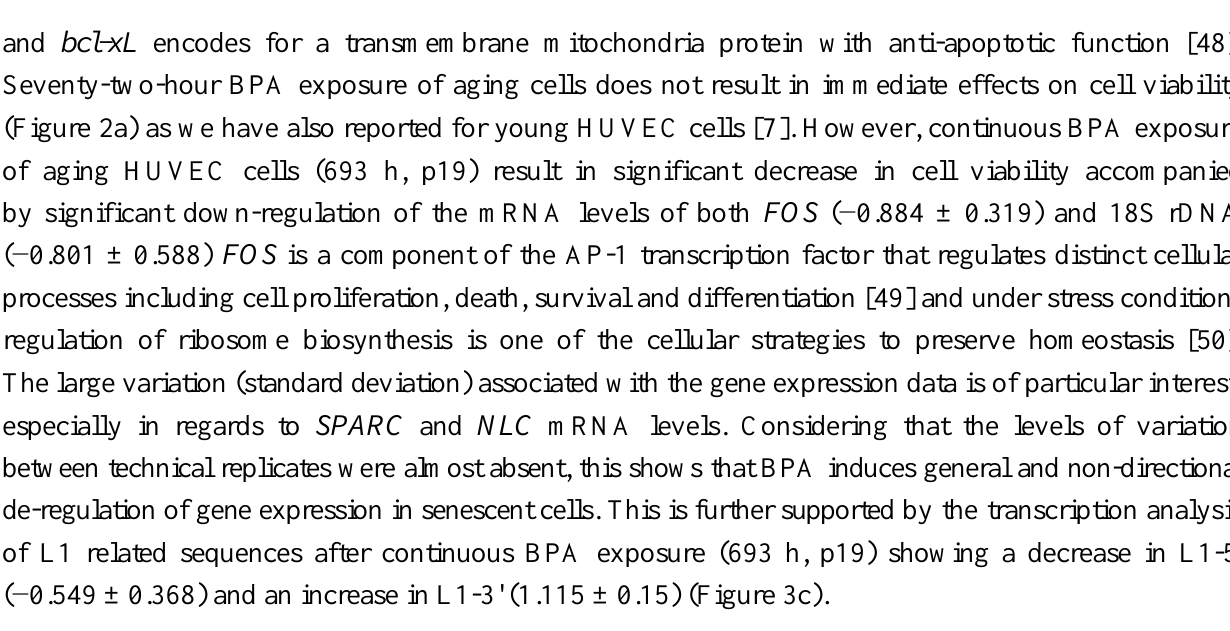
Figure 3. Quantitative Real-Time Polymerase Chain Reaction (qRT-PCR) evaluation of osteonectin ( SPARC ), fibronectin ( FN1 ), p21 , FOS , bcl-xl , nucleolin ( NCL ) and 18S rRNA transcription on ( a ) young (p6) and aging (p12) HUVEC cells after 72 h of 1 µg/mL BPA exposure and ( b ) aging HUVEC (p19) after prolonged (693 h) exposure to BPA 1 µg/mL; ( c ) L1-5' and L1-3' transcription levels on aging HUVEC after prolonged exposure to BPA 1 µg/mL (p19, 693 h). Results are shown as the mean log2 fold change (2 −ΔΔ C t ) ±